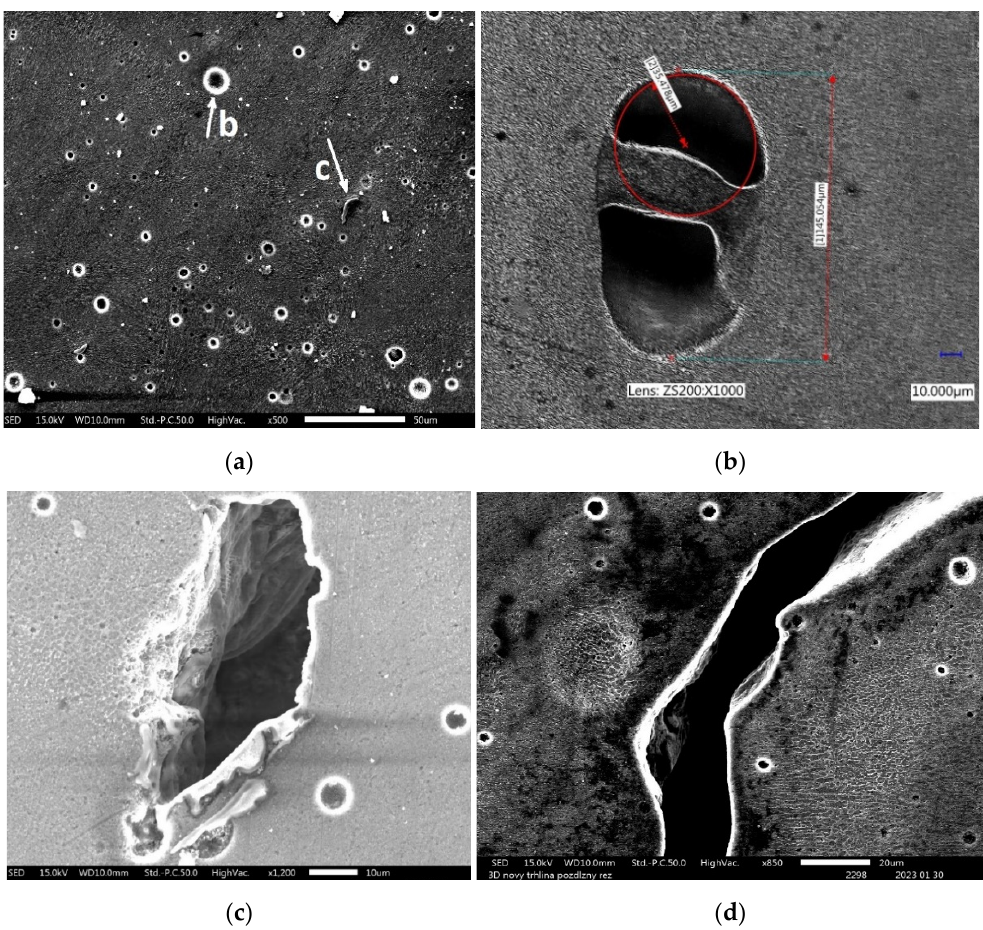
Figure 7. ( a ) Defects in AM material; ( b ) detail of a defect after missing grain of powder; ( c ) detail of